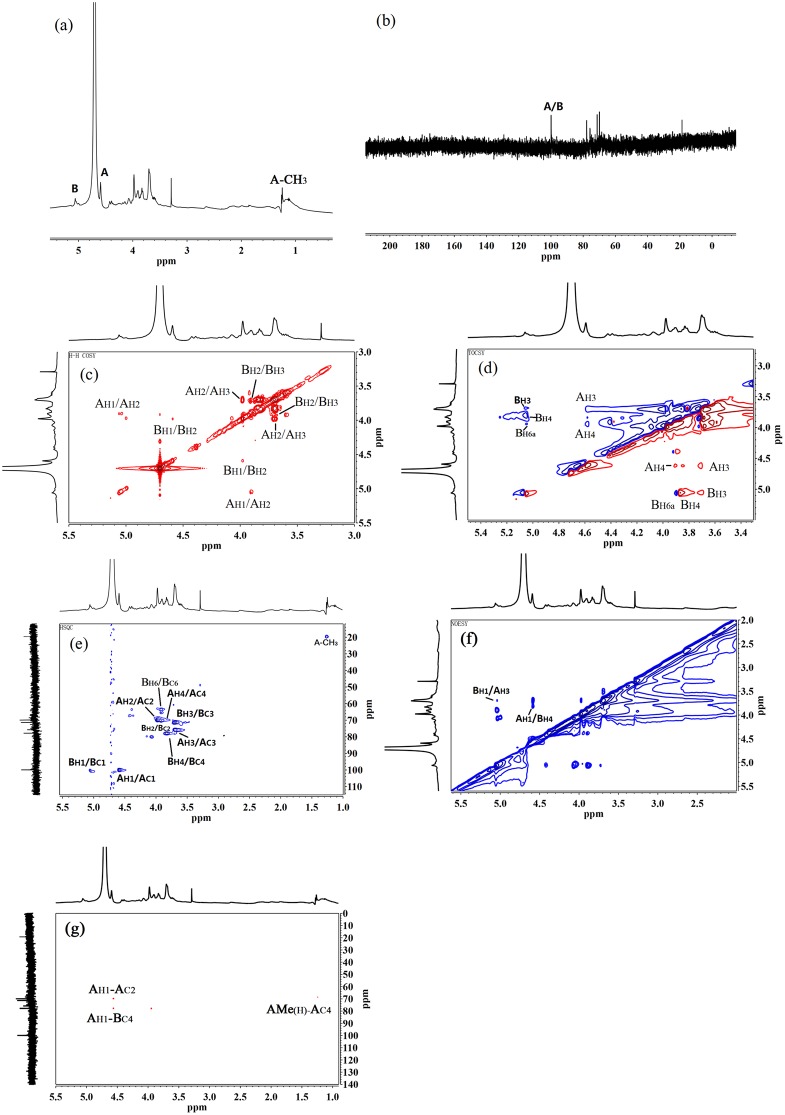
1H NMR (a), 13C NMR (b), 1H-1H COSY (c), TOCSY (d), HSQC (e), NOESY (f) and HMBC (g) spectra of STSP-I.The anomeric protons were labeled A and B.